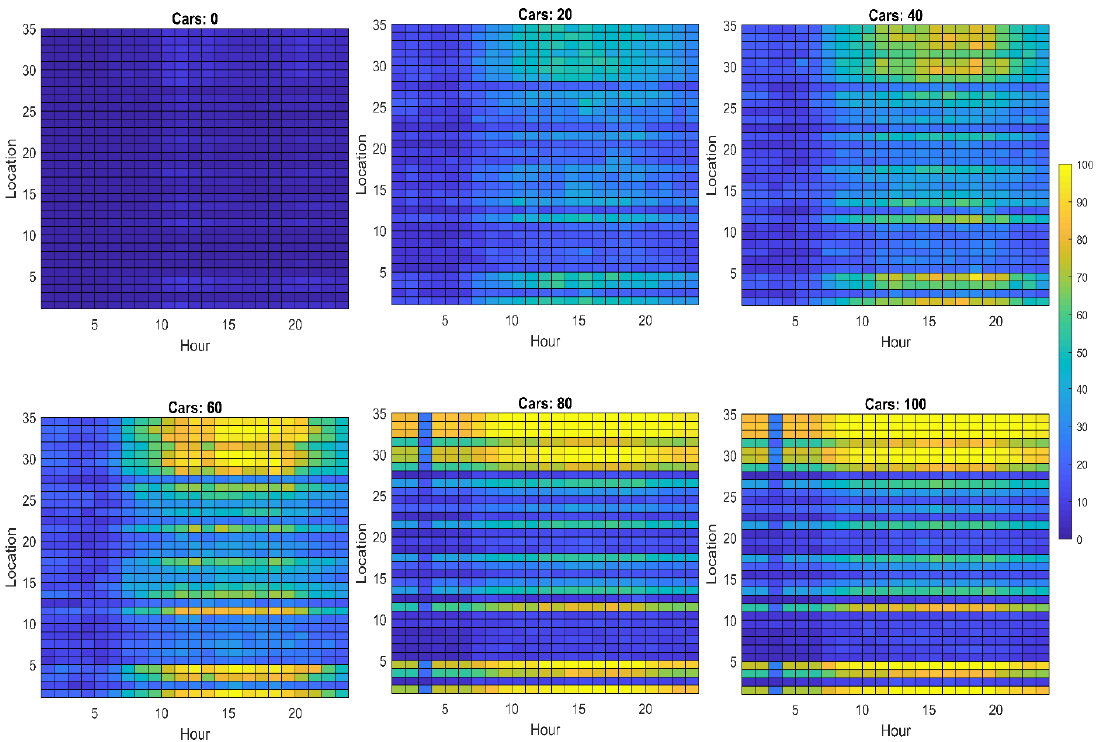
Figure A3. Maximum cable loading (percentage) observed across network 2 over varying EV penetration and time of day.